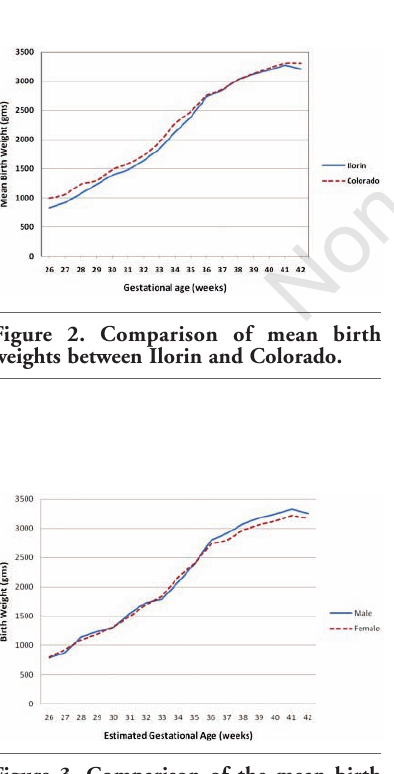
Figure 3. Comparison of the mean birth weights by